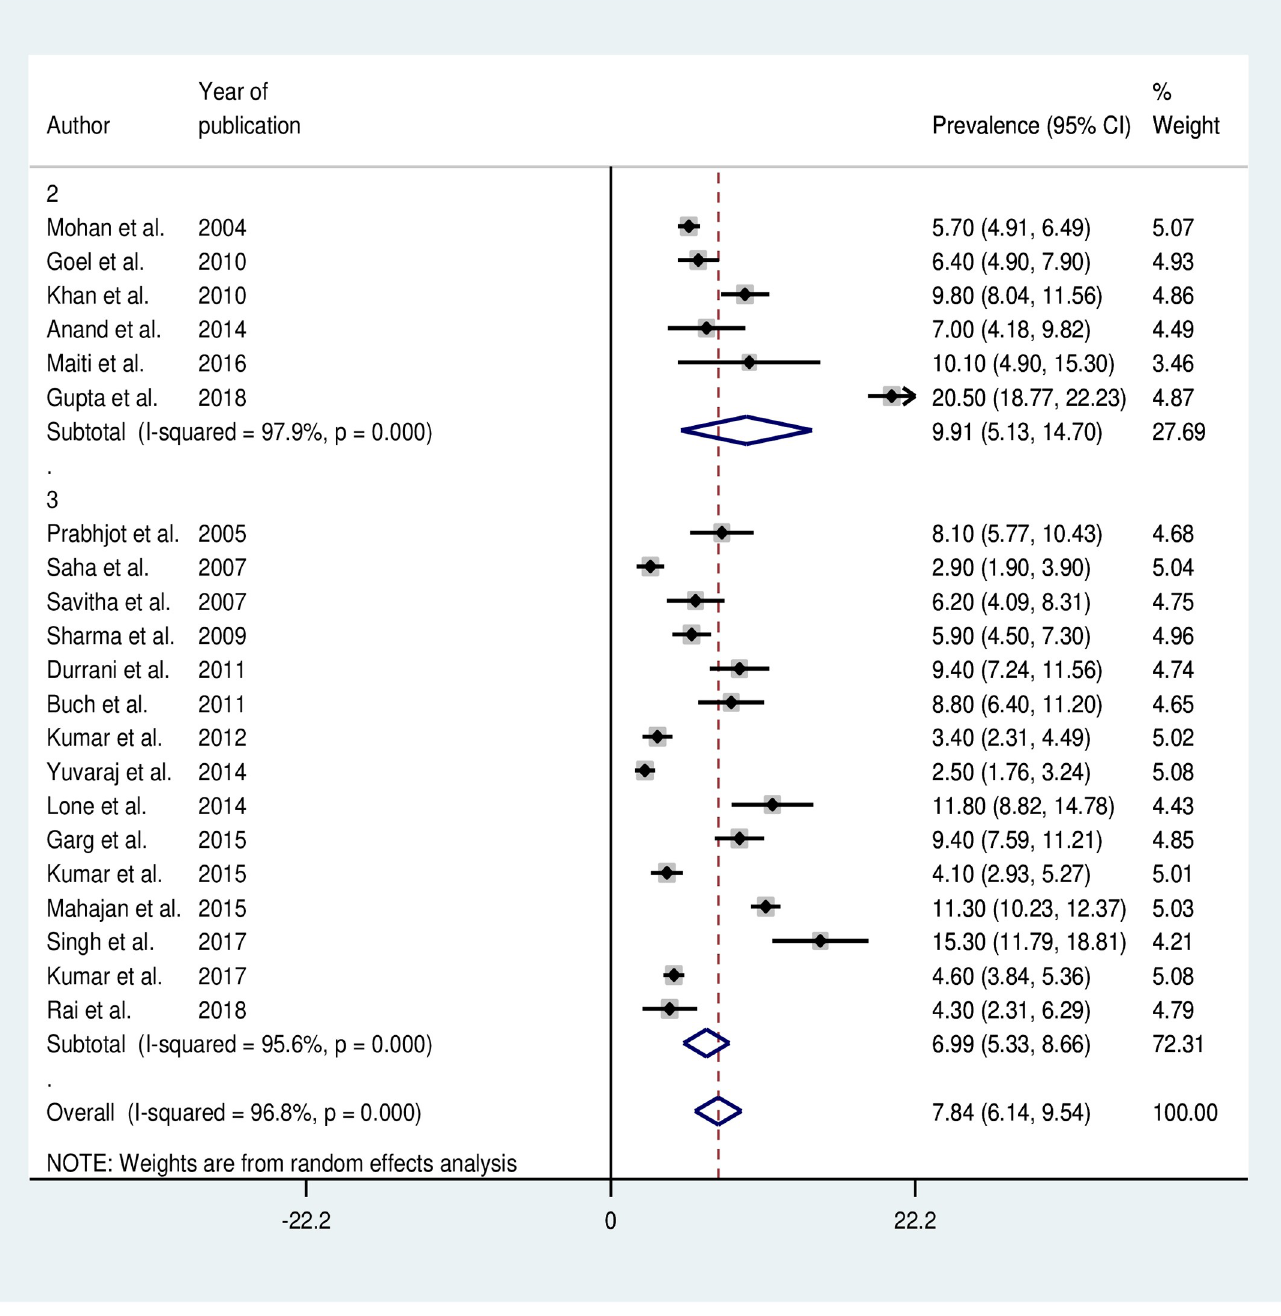
Fig 4. Forest plot of prevalence of hypertension with two and three blood pressure readings among adolescents in India.